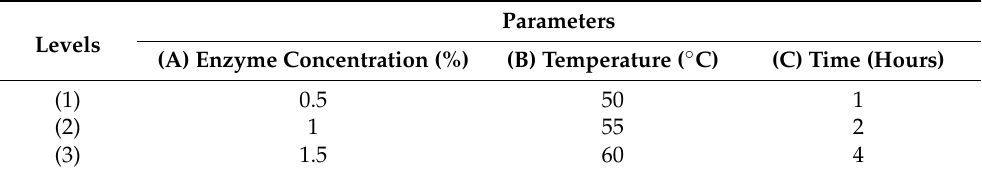
Table 1. Parameters and their